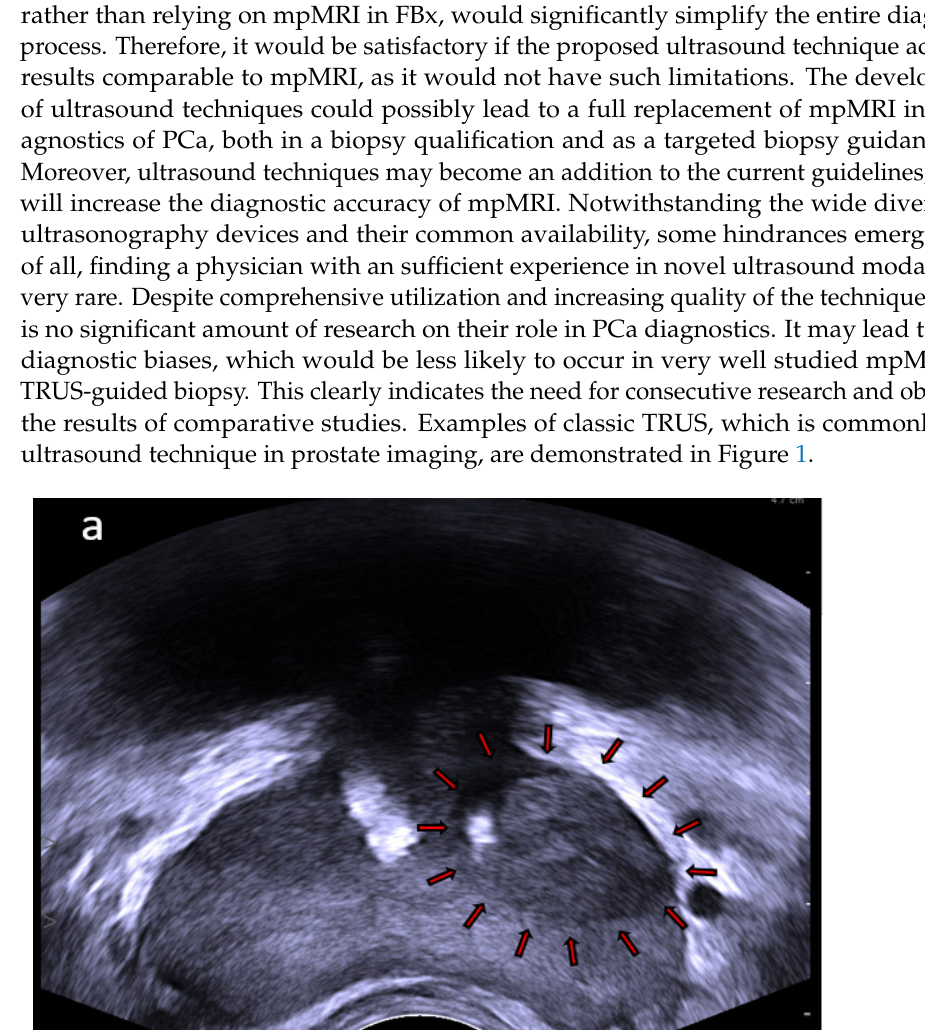
Figure 1. TRUS images: ( a ) prostate with a left side lesion (arrows); ( b ) prostate with a 16 × 12 mm lesion (arrows); and ( c ) prostate with a drawn area of known cancer (arrows). Images provided courtesy of BK Medical.